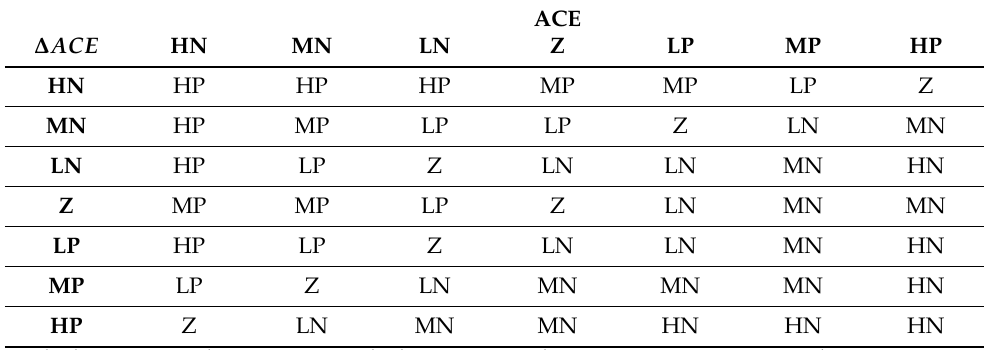
Table 2. Rule bases of the proposed